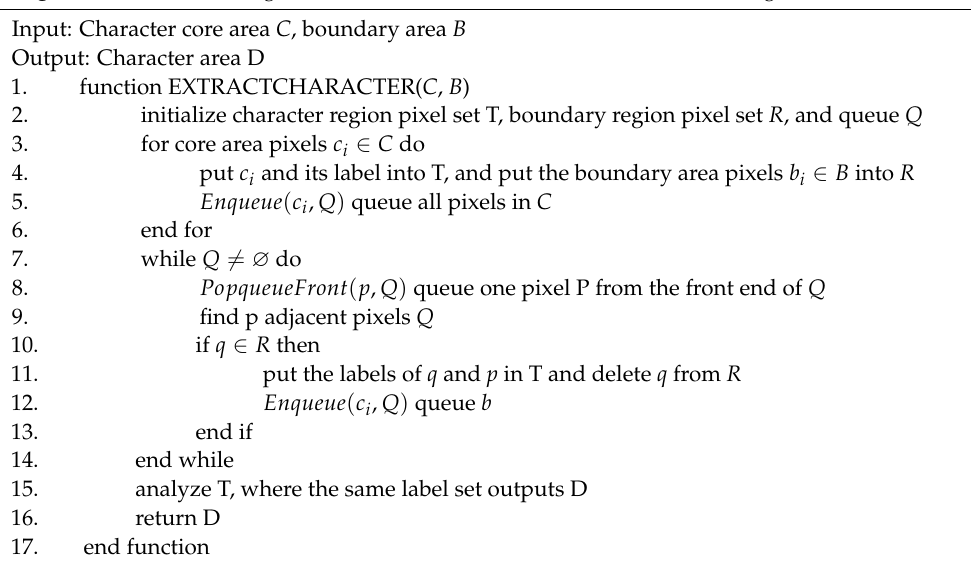
Figure 6. Shared boundary character region extraction schematic. The meaning of color is the same as that in Figure 5. Algorithm 1 Character region extraction based on the breadth-first search algorithm